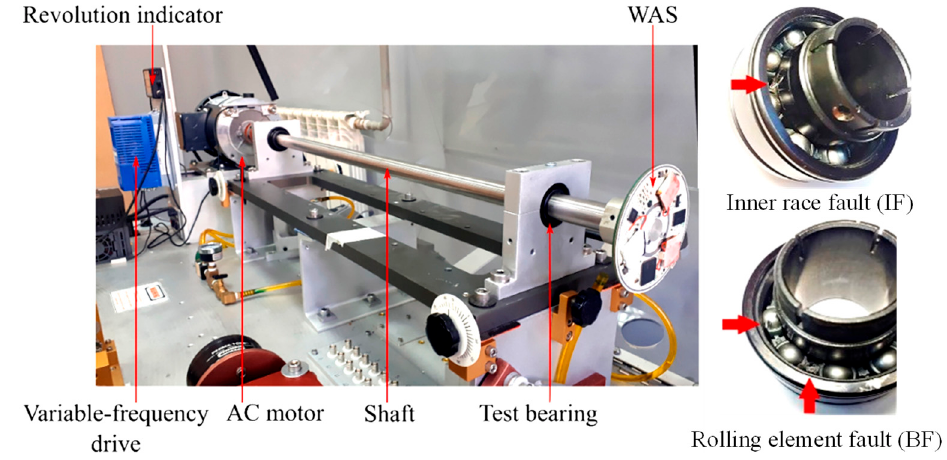
Figure 14. Bearing fault experiment rig and faulty bearings.